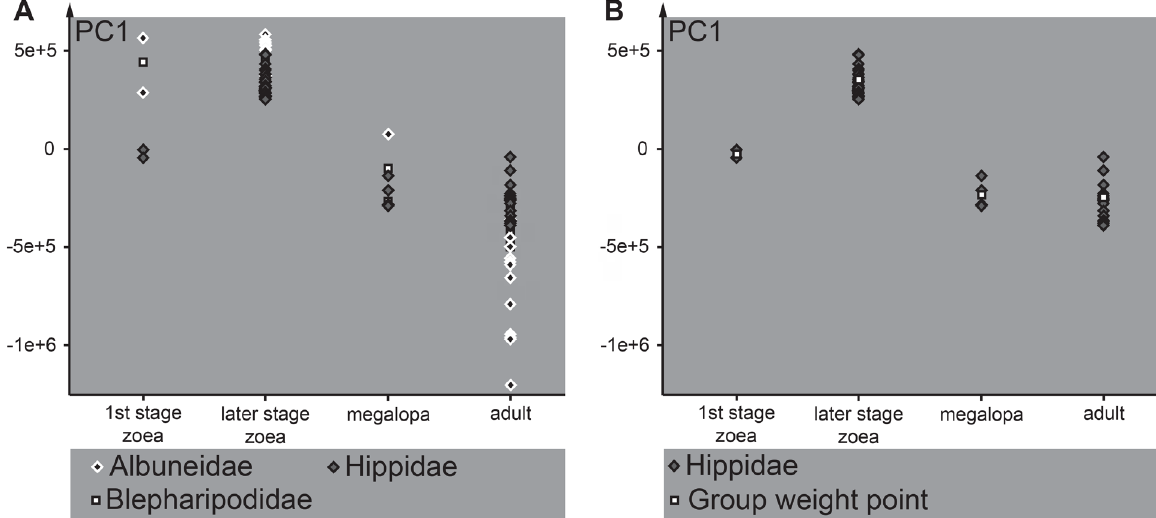
Figure 7. Plot of the first principal component resulting from the principal component analysis (PCA) performed on the data generated by an elliptic Fourier transformation of shield reconstruction drawings of the group Hippoidea. Principal component one (PC1) explains 86.1 % of apparent diversity in the data set. Factor loadings given in the Appendix (App. 2). A : All specimens included in the analysis. B : Representatives of Hippidae, with the addition of weight points to each developmental group for a clearer illustration of developmental